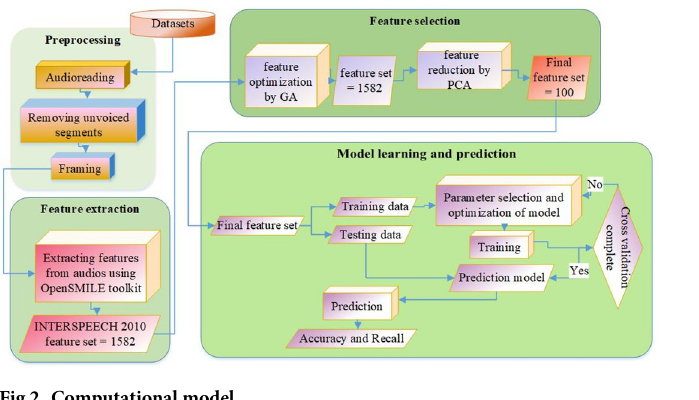
Fig 2. Computational